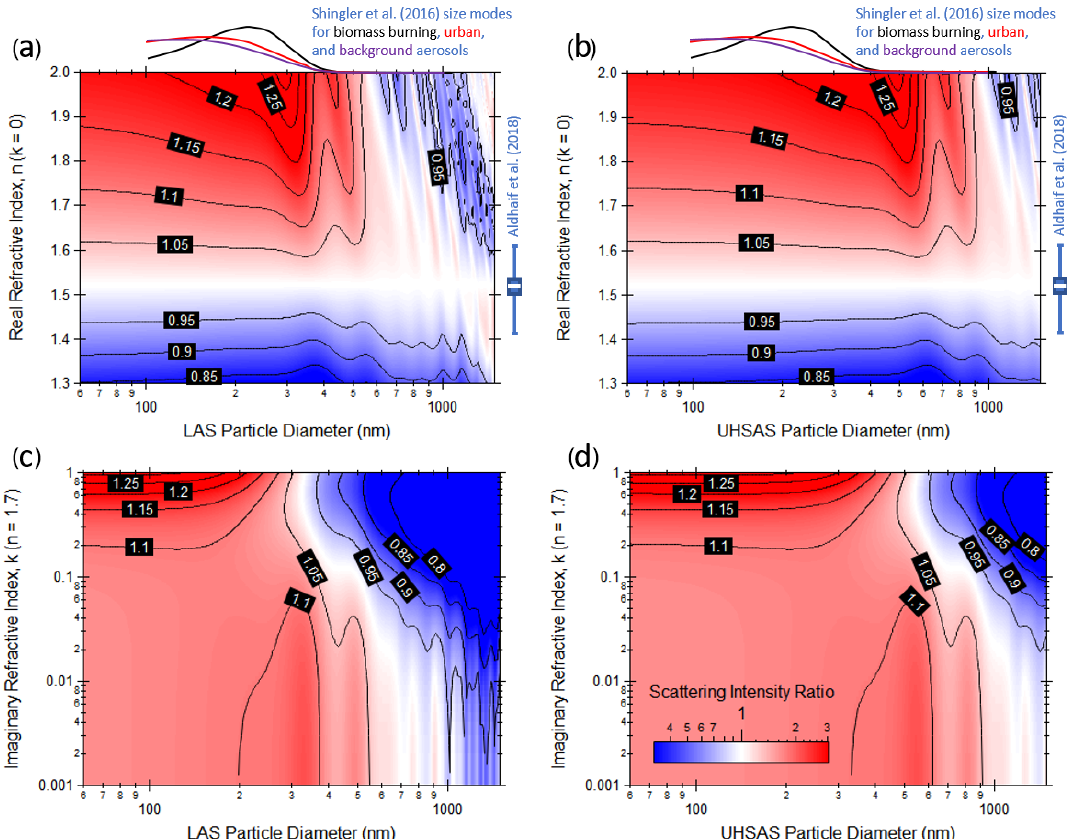
Figure 1. Mie theory calculations of size-resolved particle scattering normalized to that for ammonium sulfate (1 . 52 + 0 i ) at the LAS laser wavelength of 633nm (a, c) and the UHSAS laser wavelength of 1054nm (b, d) . In panels (a) and (b) , the imaginary part of the refractive index is held constant at zero, while for panels (c) and (d) , the real part of the refractive is held constant at 1.7. The colored shading represents the ratio of the theoretical particle scattering cross section, while the contours approximate the expected sizing ratio, which is assumed to be equal to the sixth root of the scattering cross section ratio (reasonable for diameters below 300–600nm). Average number size distribution modes for relevant atmospheric aerosol types from Shingler et al. (2016) are shown above panels (a) and (b) to illustrate the typical atmospheric aerosol size range, while the range of real RIs reported by Aldhaif et al. (2018) are shown to the right of these panels to illustrate the typical range of atmospherically relevant real